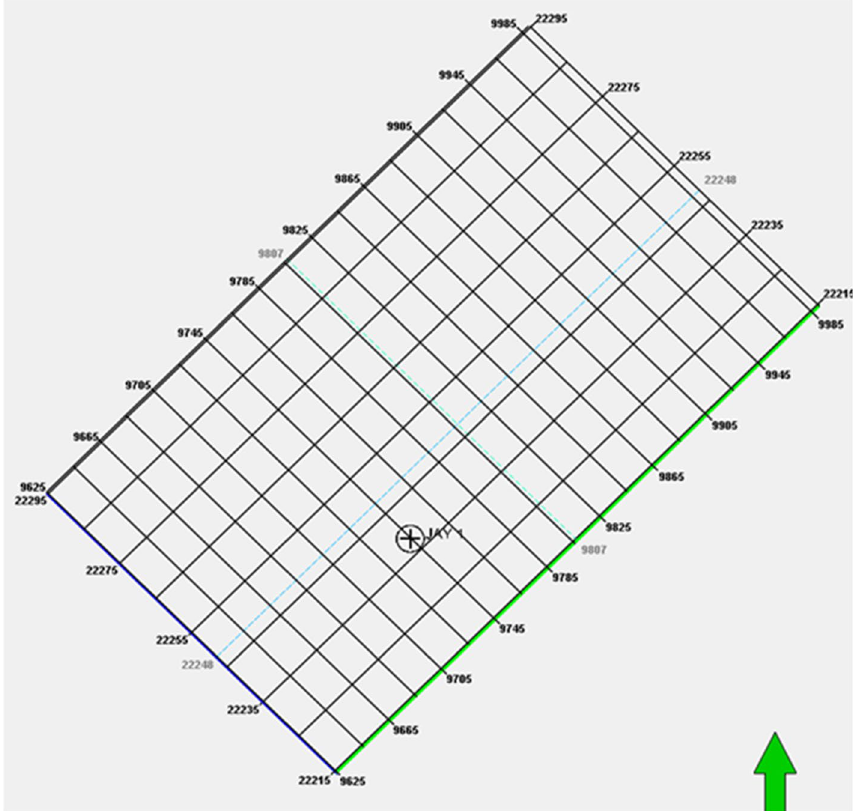
Fig. 6 The 3D seismic survey layout and Jay-1 well